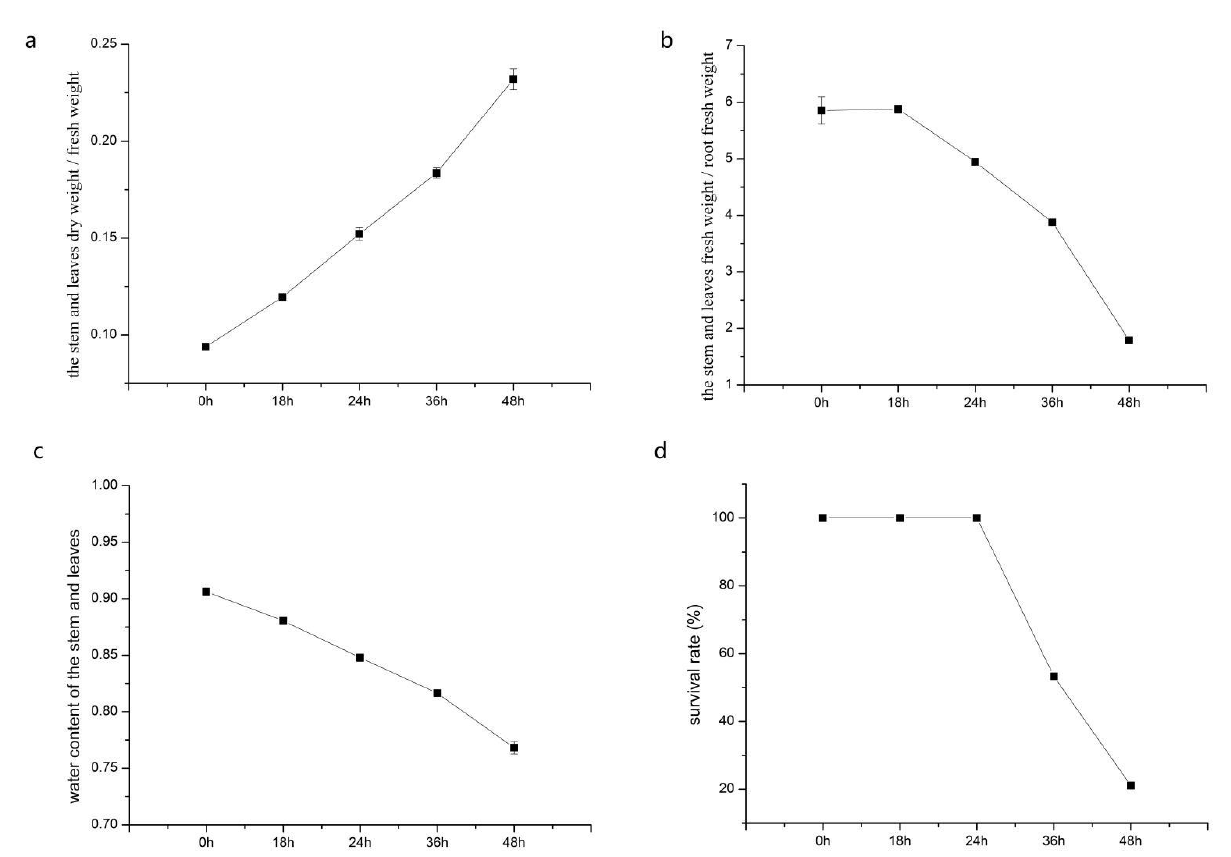
Figure 1. Physiological changes of Jerusalem artichoke in response to drought stress. ( a ) Changes of the stem and leaves dry weight/fresh weight from 0 to 48 h; ( b ) changes of the stem and leaves fresh weight/root fresh weight from 0 to 48 h; ( c ) changes of the water content of stems and leaves from 0 to 48 h; ( d ) changes of the survival rate in the Jerusalem artichoke from 0 to 48 h.